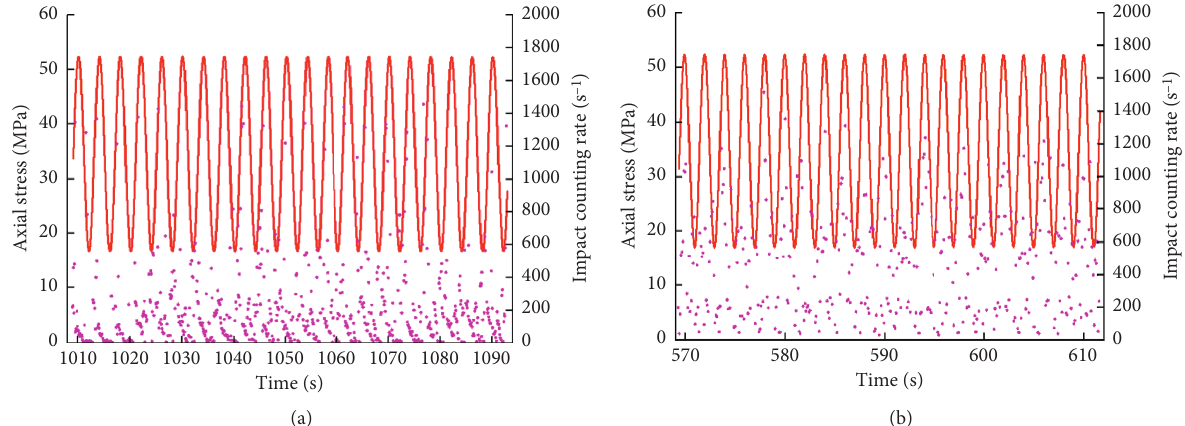
Figure 9: Acoustic emission impact counting rate under the same confining pressure and stress level and different cyclic loading frequency. (a) MB-3, 0.25 Hz and (b) MB-4, 0.5